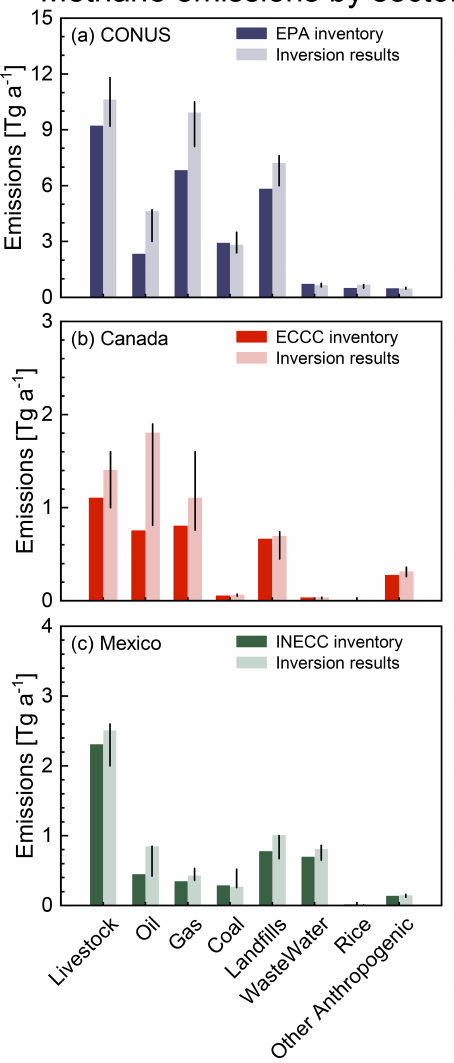
Figure 7. Mean 2010–2017 anthropogenic methane emissions by source sectors for the contiguous US (CONUS), Canada, and Mex- ico, displaying values and ranges from the corresponding Table 1a– c. The official UNFCCC-reported national inventories for the US (EPA), Canada (ECCC), and Mexico (INECC) are used as prior es- timates for the inversion. Inversion results are from the base inver- sion of GOSAT + in situ observations, and the ranges are for the ensemble of 66 sensitivity inversions (Table 2) and sectoral attribu- tion methods (Sect.